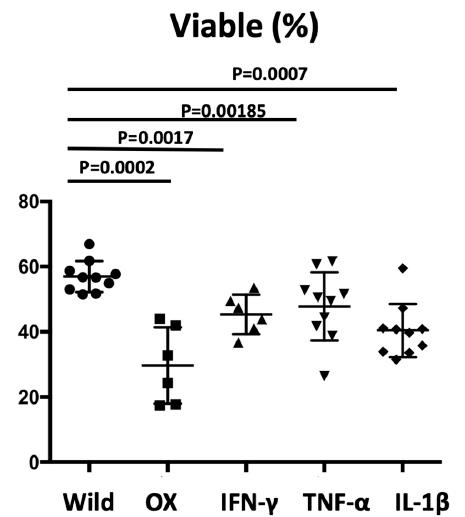
Figure 7. Sperm viability by repeated hapten application and intraperitoneal injection of recombinant proteins. In the oxazolone applied dermatitis model, the sperm viability was significantly decreased ( p = 0.0002). On the other hand, intraperitoneal administration of inflammatory cytokines, recombinant interferon- γ (INF- γ ), tumor necrosis factor- α (TNF- α ), and interleukin (IL)-1 β resulted in the decreased sperm viability compared to phosphate-bu ff ered saline (PBS) injection ( p = 0.0017, p = 0.0185, and p = 0.0007, respectively). However, no significant di ff erence between each cytokine administered was